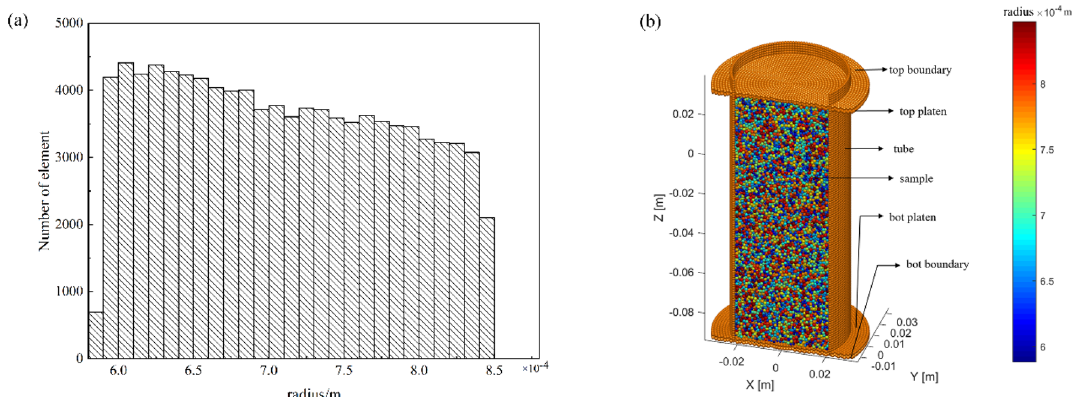
Figure 5. ( a ) The size distribution of elements; ( b ) components of the numerical